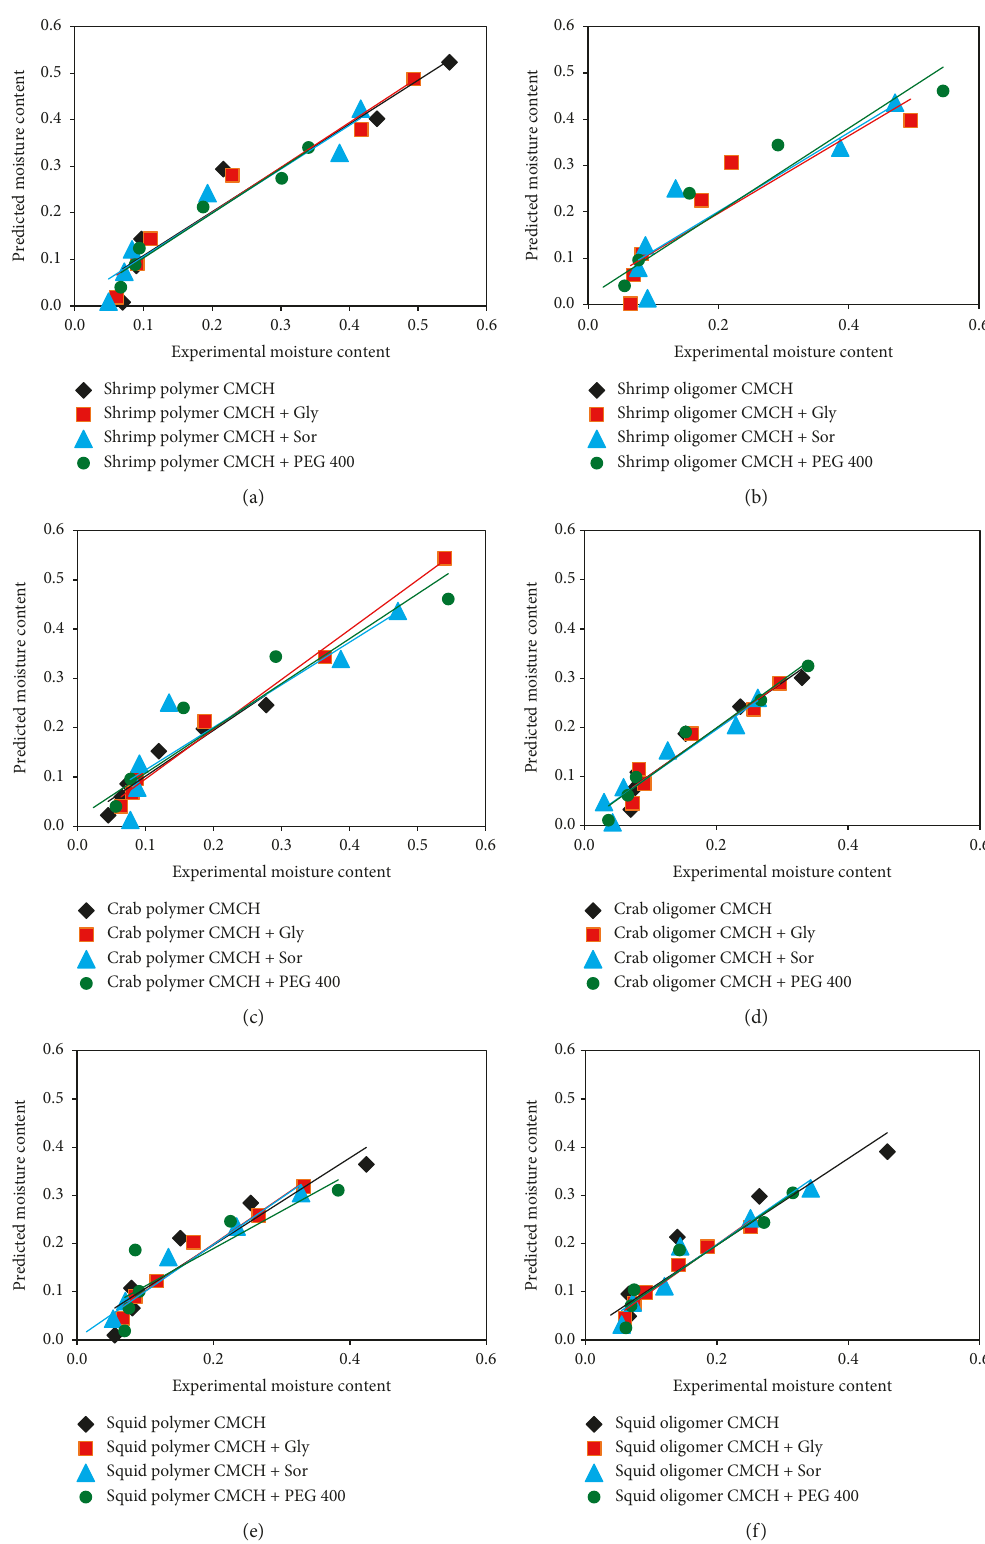
Figure 6: The comparison between the experimental moisture content values and those predicted for all the CMCH films from the Lewicki- 2 model: shrimp polymer CMCH films (a); shrimp oligomer CMCH films (b); crab polymer CMCH films (c); crab oligomer CMCH films (d); squid polymer CMCH films (e); squid oligomer CMCH films